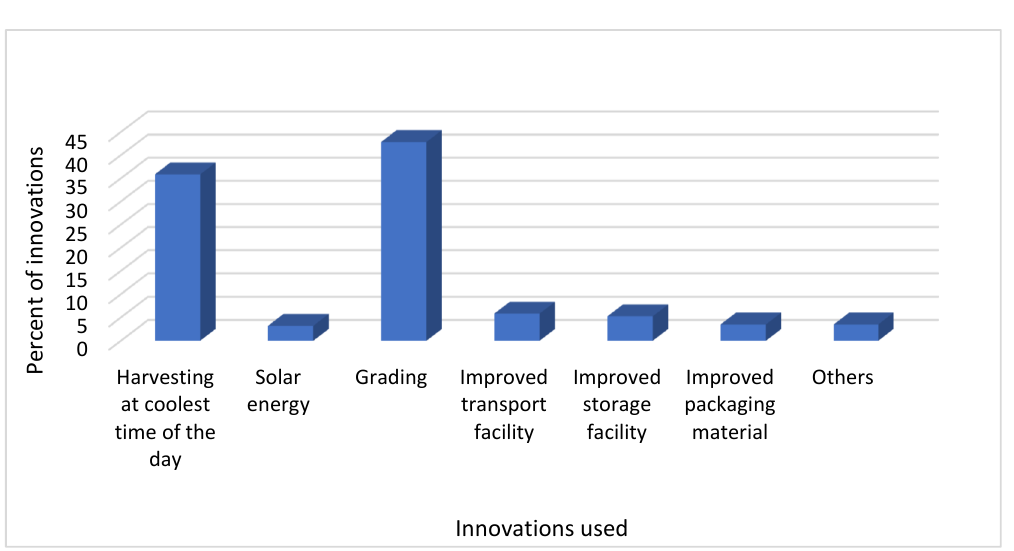
Figure 5. Postharvest Management innovation used to reduce postharvest losses.